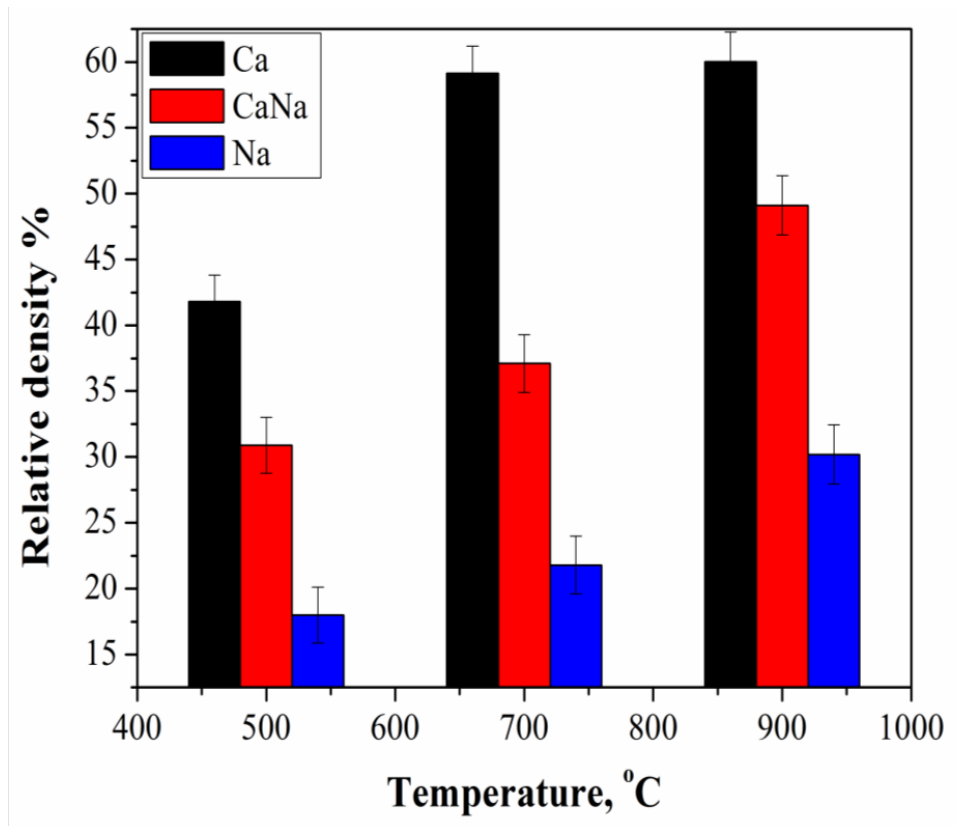
Figure 8. Relative density of ceramic samples, obtained via annealing of cement-salt stone in the temperature range of 500 – 900 °C.